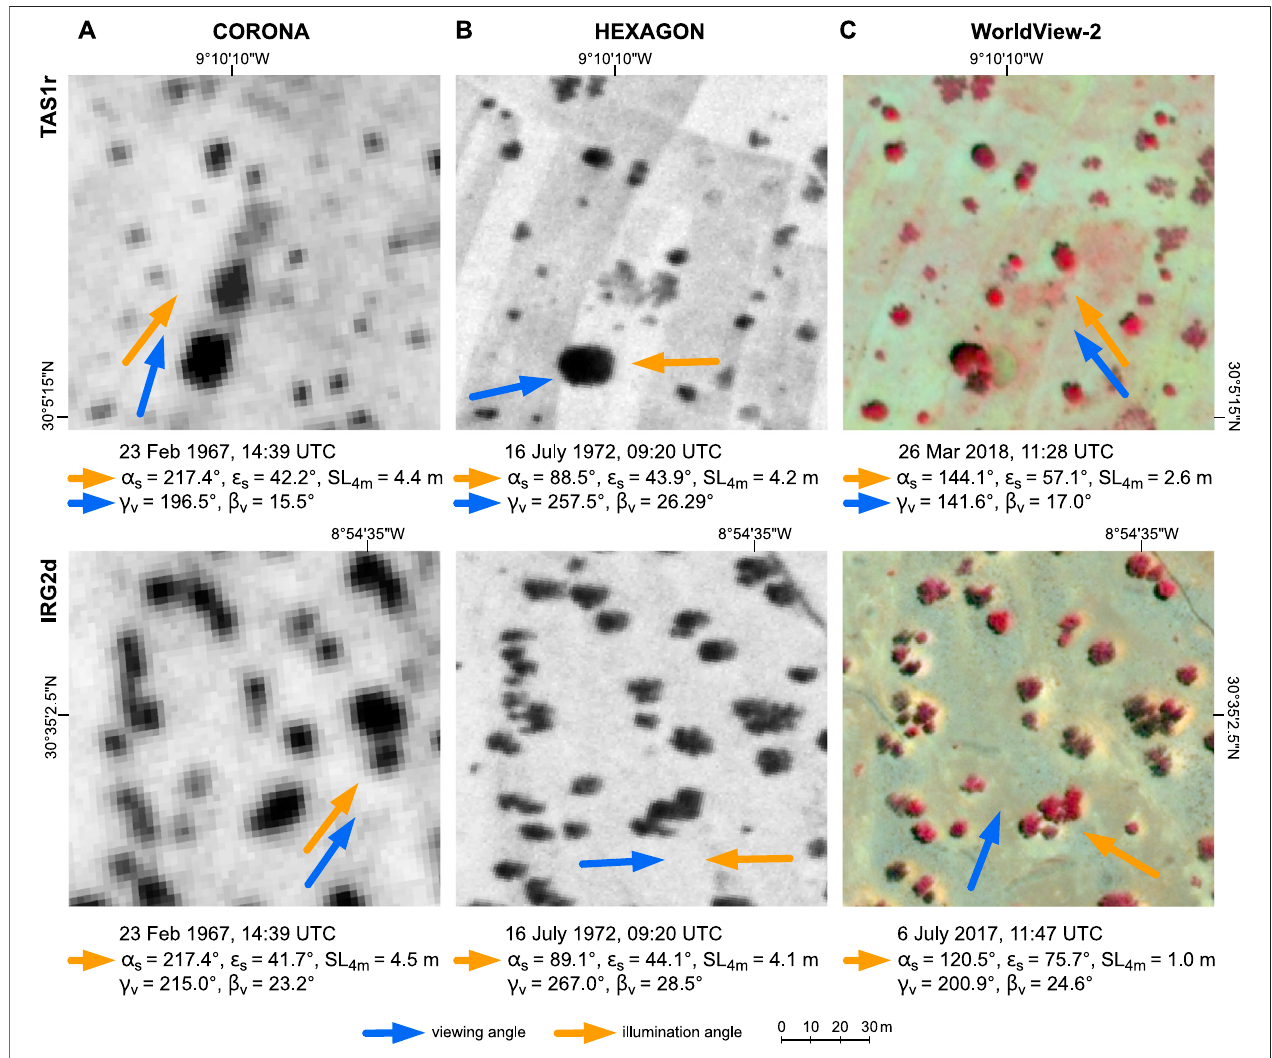
FIGURE 3 | Combined effects of varying spatial resolutions, illumination angles (orange arrows) and viewing angles (blue arrows) on the appearance of trees in CORONA (A) , HEXAGON (B) and false-colour infrared WorldView-2 (C) imagery oftest site TAS1r (top row) and IRG2d (bottom row). α S : sunazimuth; ε S :sun elevation; SL 4m : shadow length of 4 m high object; γ ν : horizontal viewing angle of camera; β ν : vertical viewing angle of camera. Note the 5-years gap between the two historical image dates and the change of tree cover in the centre of